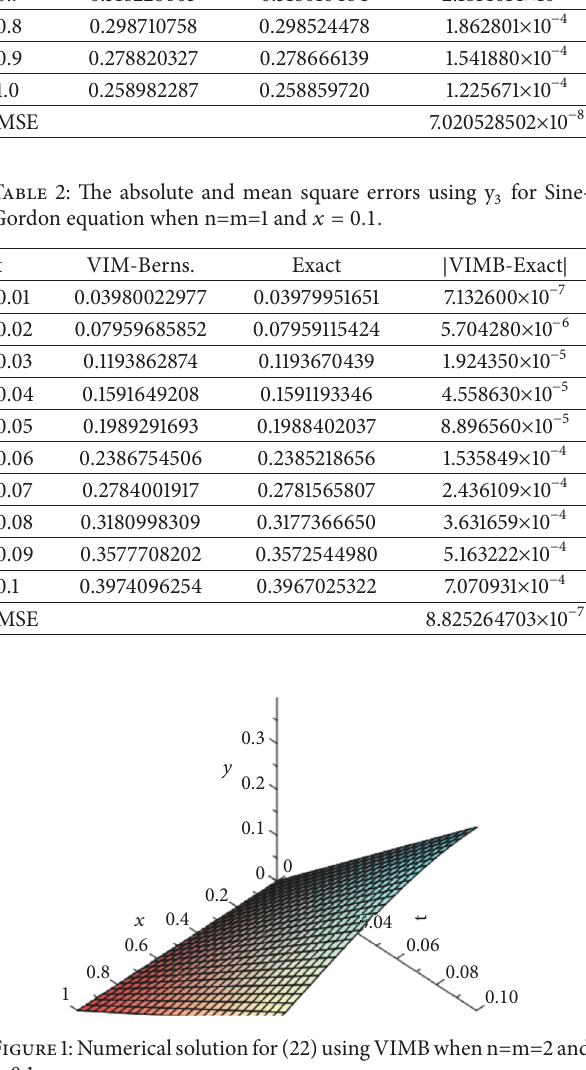
Table 2. The maximum errors generated using the modified Bernstein polynomial are of 10 −4 .